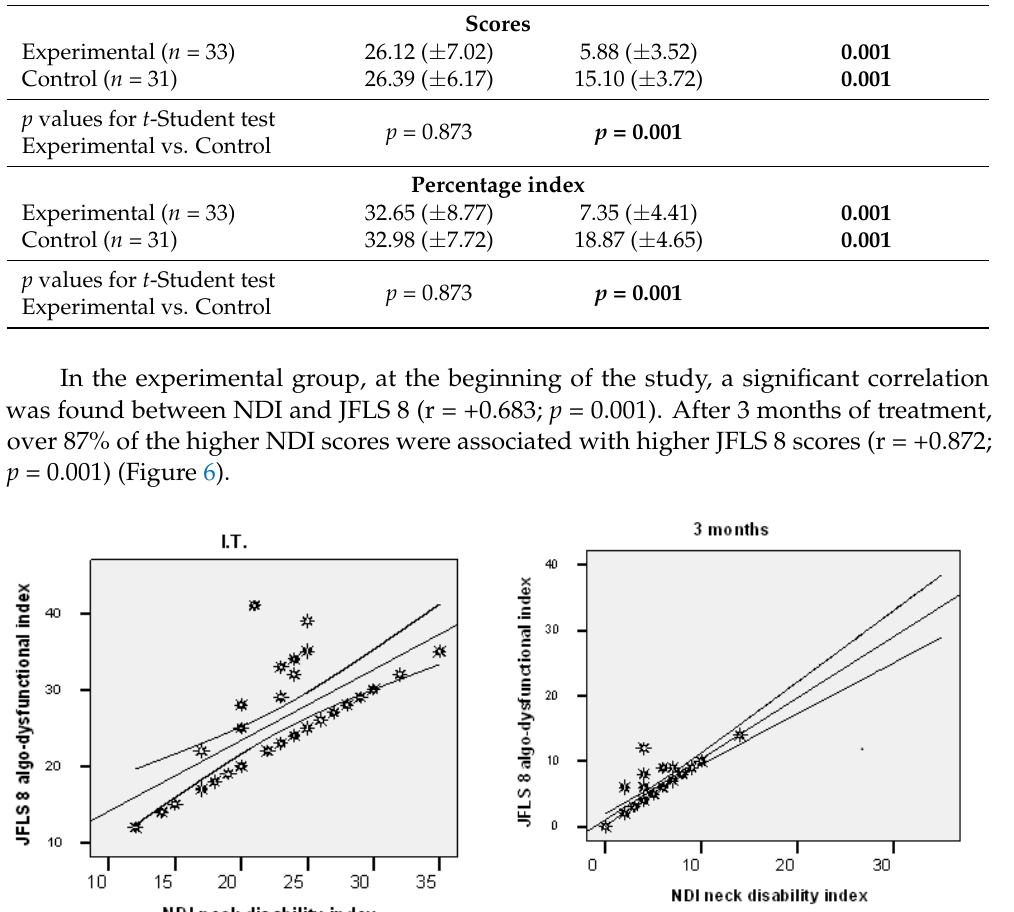
Figure 6. Correlation between NDI and JFLS 8 in the experimental group.